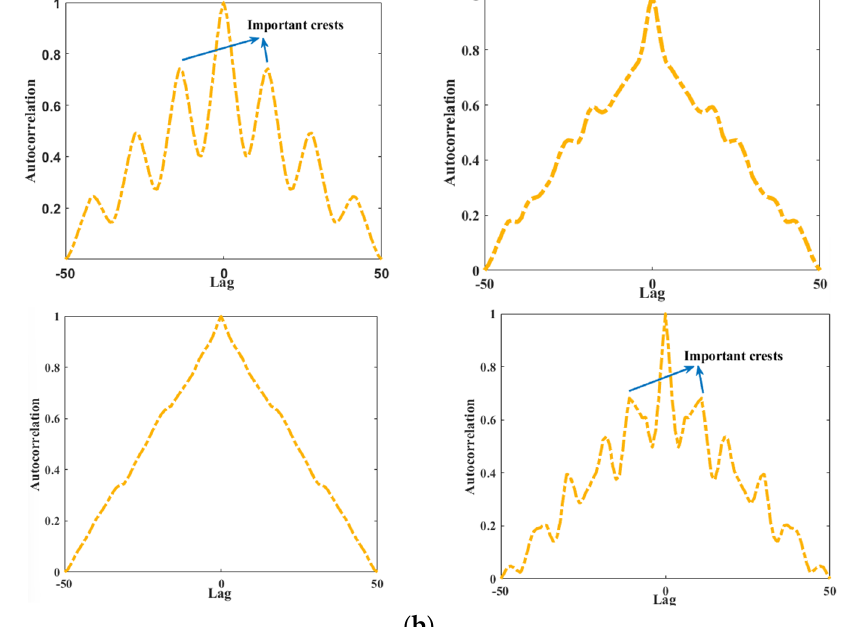
Figure 6. Autocorrelation function graph in different texture states. ( a ) is a simulated SAR image with four textures, ( b ) contains four autocorrelation function images of different textures.